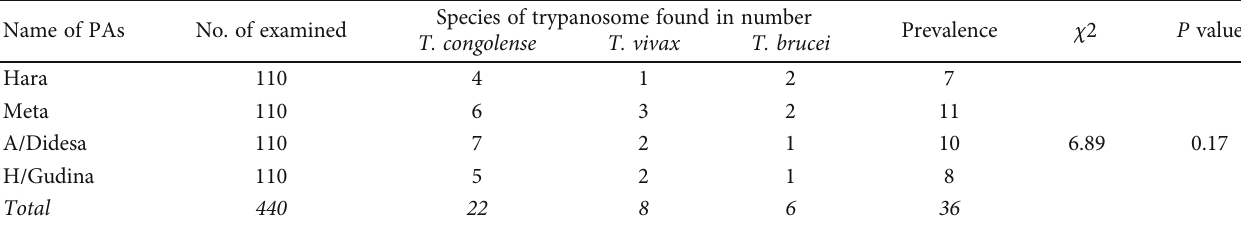
Table 3: Prevalence of identi fi ed trypanosomes species in the study area.